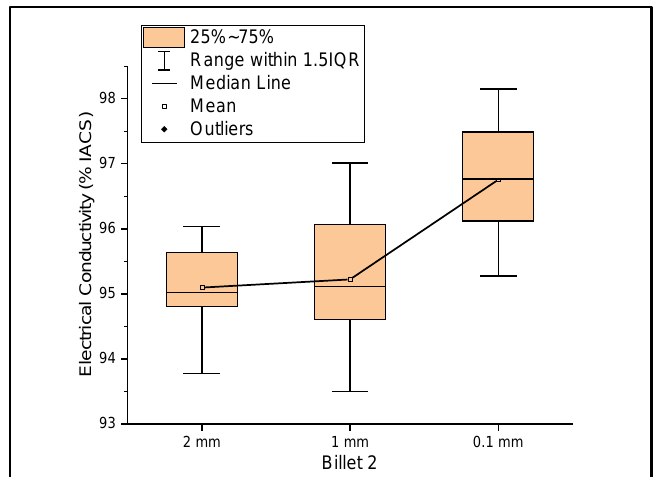
Figure 2 . The electrical conductivity of Billet 2 at different cross-sectional sizes. Figure 2. The electrical conductivity of Billet 2 at different cross-sectional